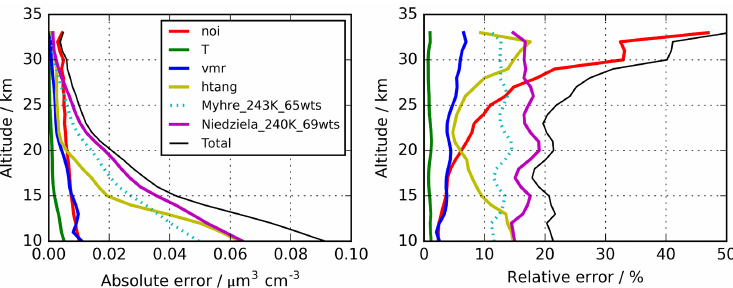
Figure 2. Altitude-dependent estimated errors for the retrieval of H 2 SO 4 –H 2 O aerosol volume densities. Solid lines indicate the uncertainties used to calculate the “total” error. Indicated errors are “noi” – single scan spectral noise; “T” – temperature uncertainty 2K; “vmr” – 10% uncertainty in volume mixing ratios of interfering gases; “htang” – 300m tangent altitude uncertainty; “Niedziela_240K_60wts” – use of optical constants by Niedziela et al. (1999) for 240K and 69wt% instead of Niedziela et al. (1999) for 230K and 75wt% H 2 SO 4 . The dotted curves (“Myhre_243K_65wts”) show the results when the optical constants of Lund Myhre et al. (2003) for a temperature of 243K and a concentration of 65wt% are used instead of those by Niedziela et al. (1999) ( T = 230K and